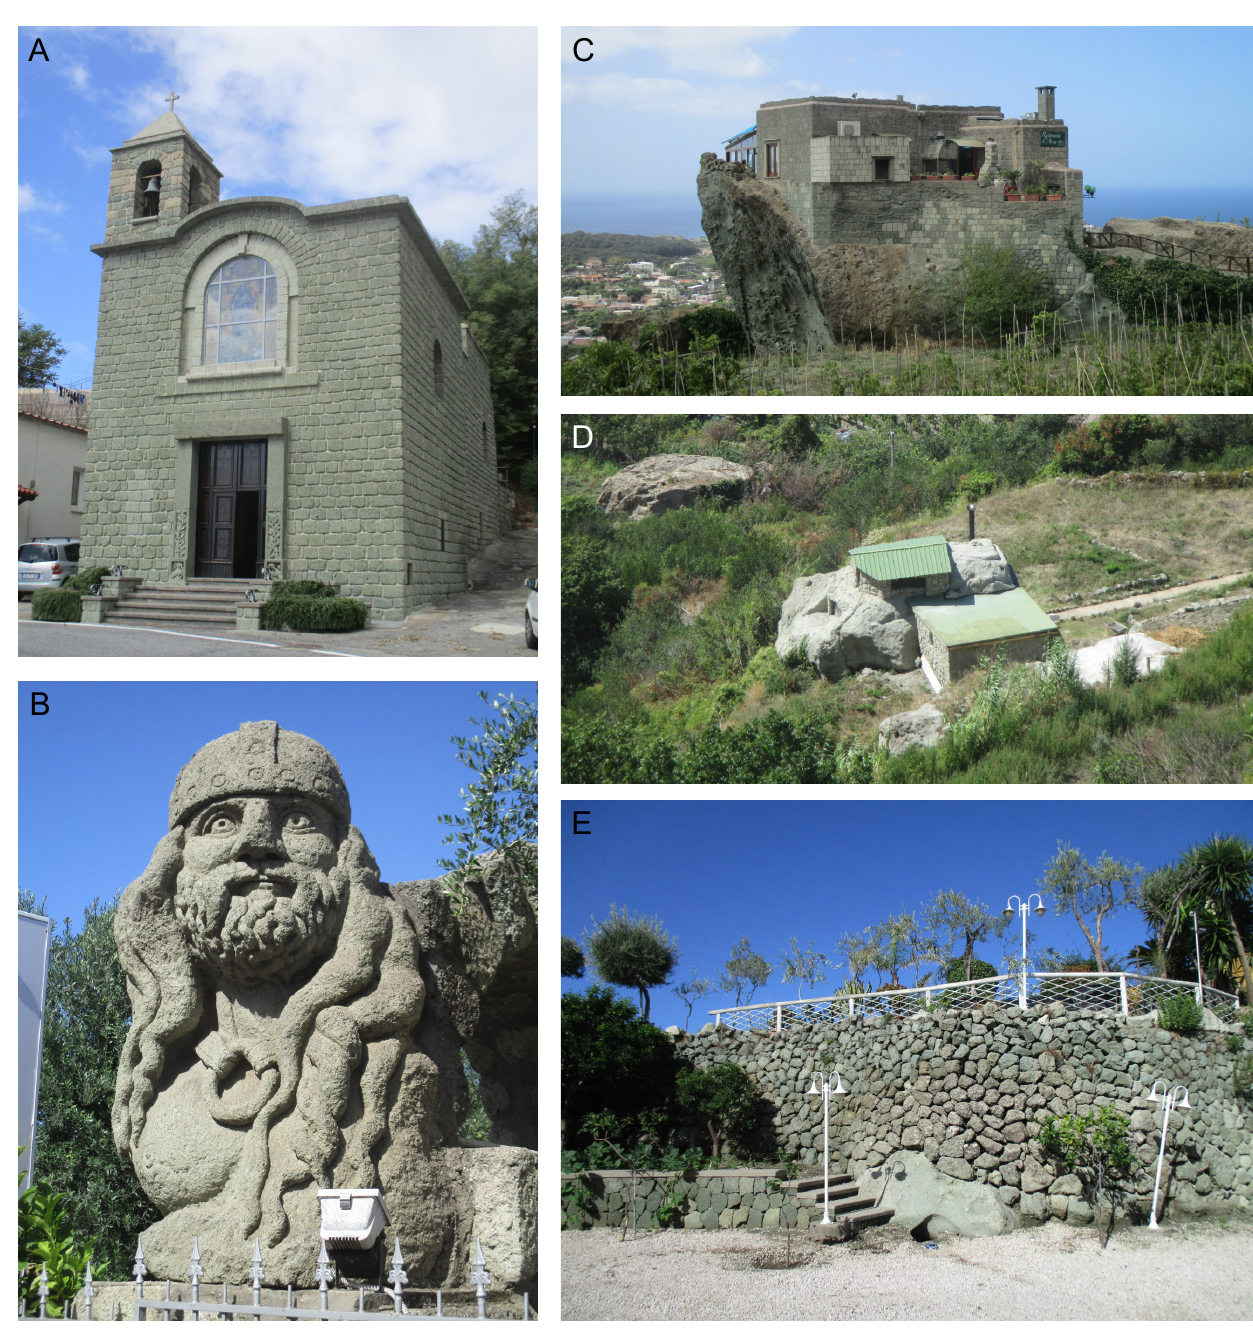
Figure 1: The use of Mt. Epomeo Green Tu ff (MEGT) in construction on Ischia Island (Italy). [A] The San Ciro church. [B] Statue carved from a block of MEGT. [C] Restaurant built using MEGT on top of a block of MEGT. [D] House built inside a block of MEGT. [E] Wall constructed using blocks of MEGT. Photo credit for all pictures: M.J.